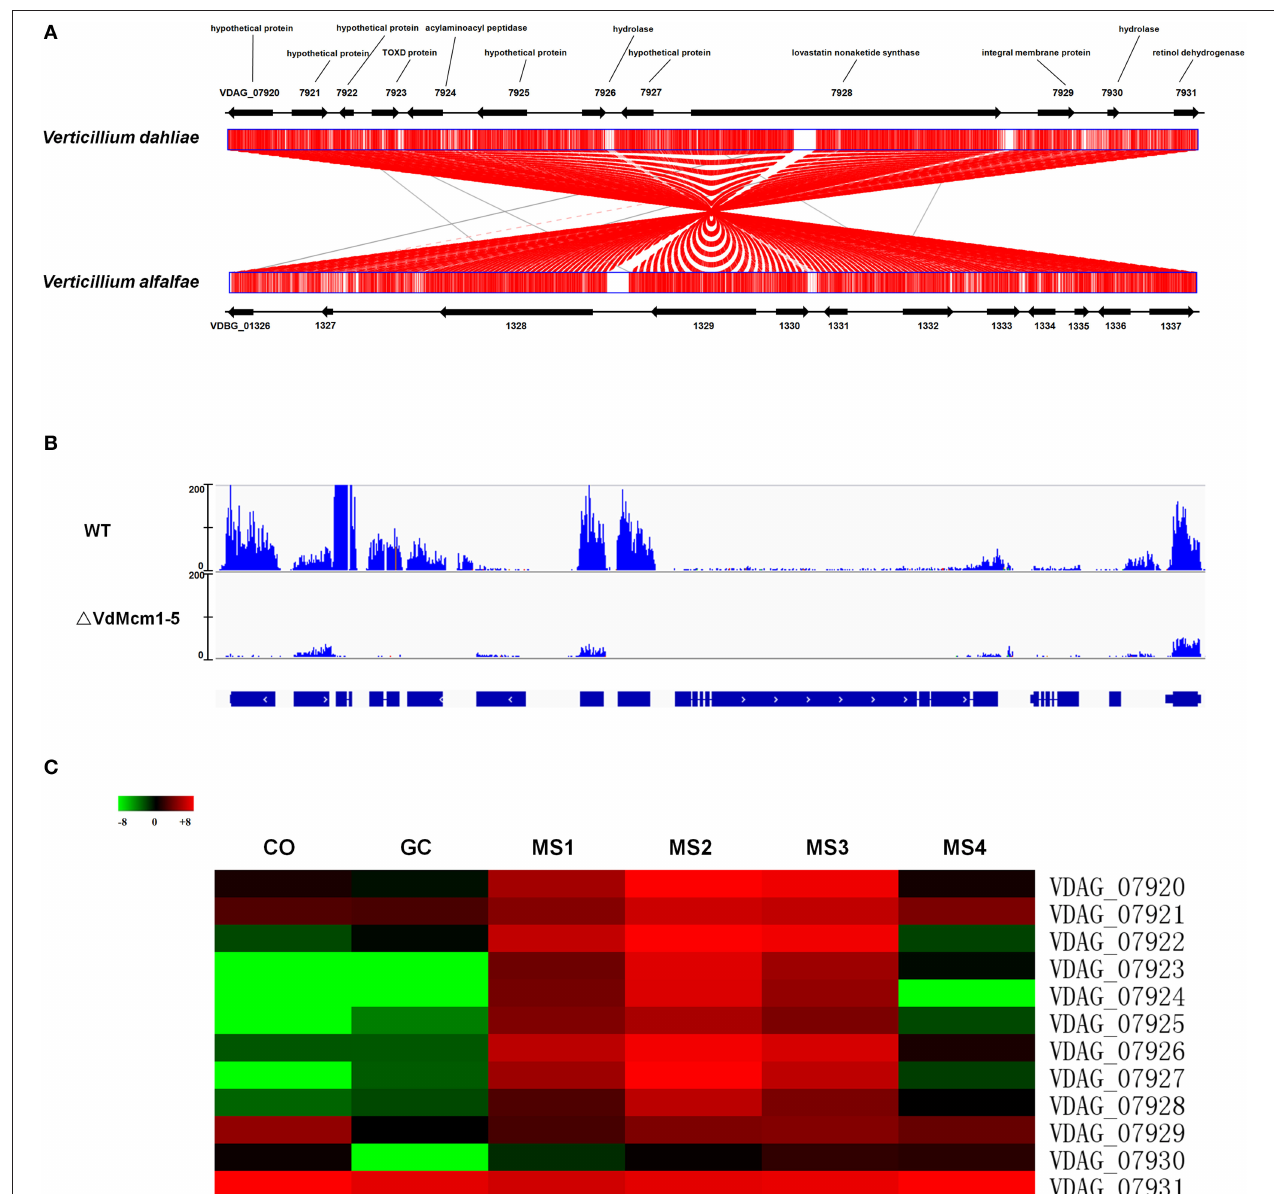
FIGURE 10 | VdMcm1 regulates genes expression of a secondary metabolism gene cluster. (A) Structure and gene annotation of the secondary metabolism gene cluster in V. dahliae and V. alfalfae . This gene cluster of V. dahliae showed high homology to that of V. alfalfae. Synteny was indicated by red lines. (B) Visualization of RNA-Seq coverage of this secondary metabolism gene cluster in wild-type strain and VdMcm1 deletion mutant. The blue curves indicated reads coverage. (C) Heatmap showing gene expression profiles of genes in the cluster during microsclerotia development. CO and GC represent conidia and conidia germination; MS1–MS4 represents four typical stages during the entire process of microsclerotia formation at 60, 72, 96 h, and 14 days. Log 2 (FPKM) value was used to draw the picture. Green color represented the negative value of Log 2 (FPKM), and red color represented the positive value of Log 2 (FPKM). Black color represented the zero value of Log 2